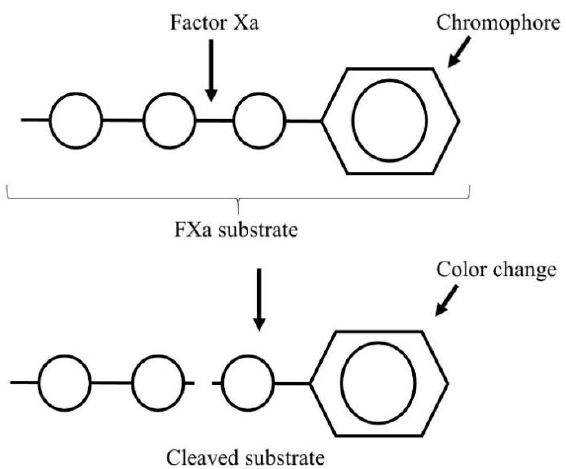
Figure 3. Schematic representation of the endogenous FXa cleavage of the chromogenic substrate, thus releasing the chromophore unit and leading to a color change.